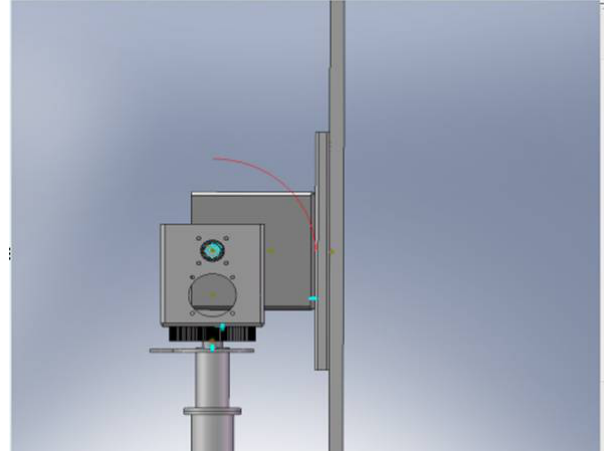
Figure 13. Pitch-axis trajectory (0°–90°).